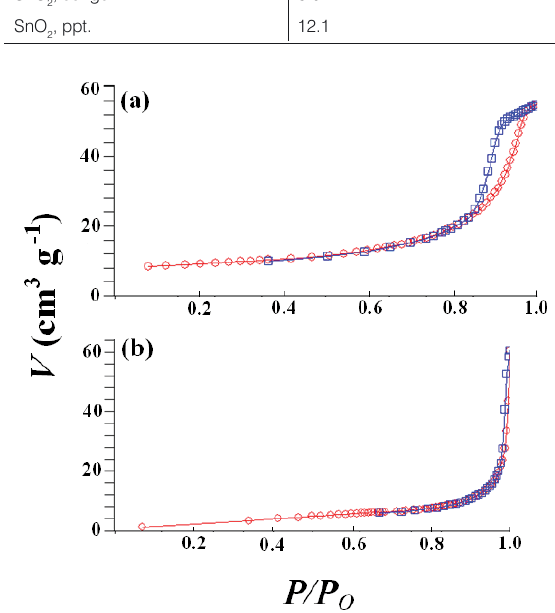
Figure 5. N adsorption-desorption isotherm of pure SnO 2 at 500°C: (a) using sol-gel and (b) direct precipitation methods.